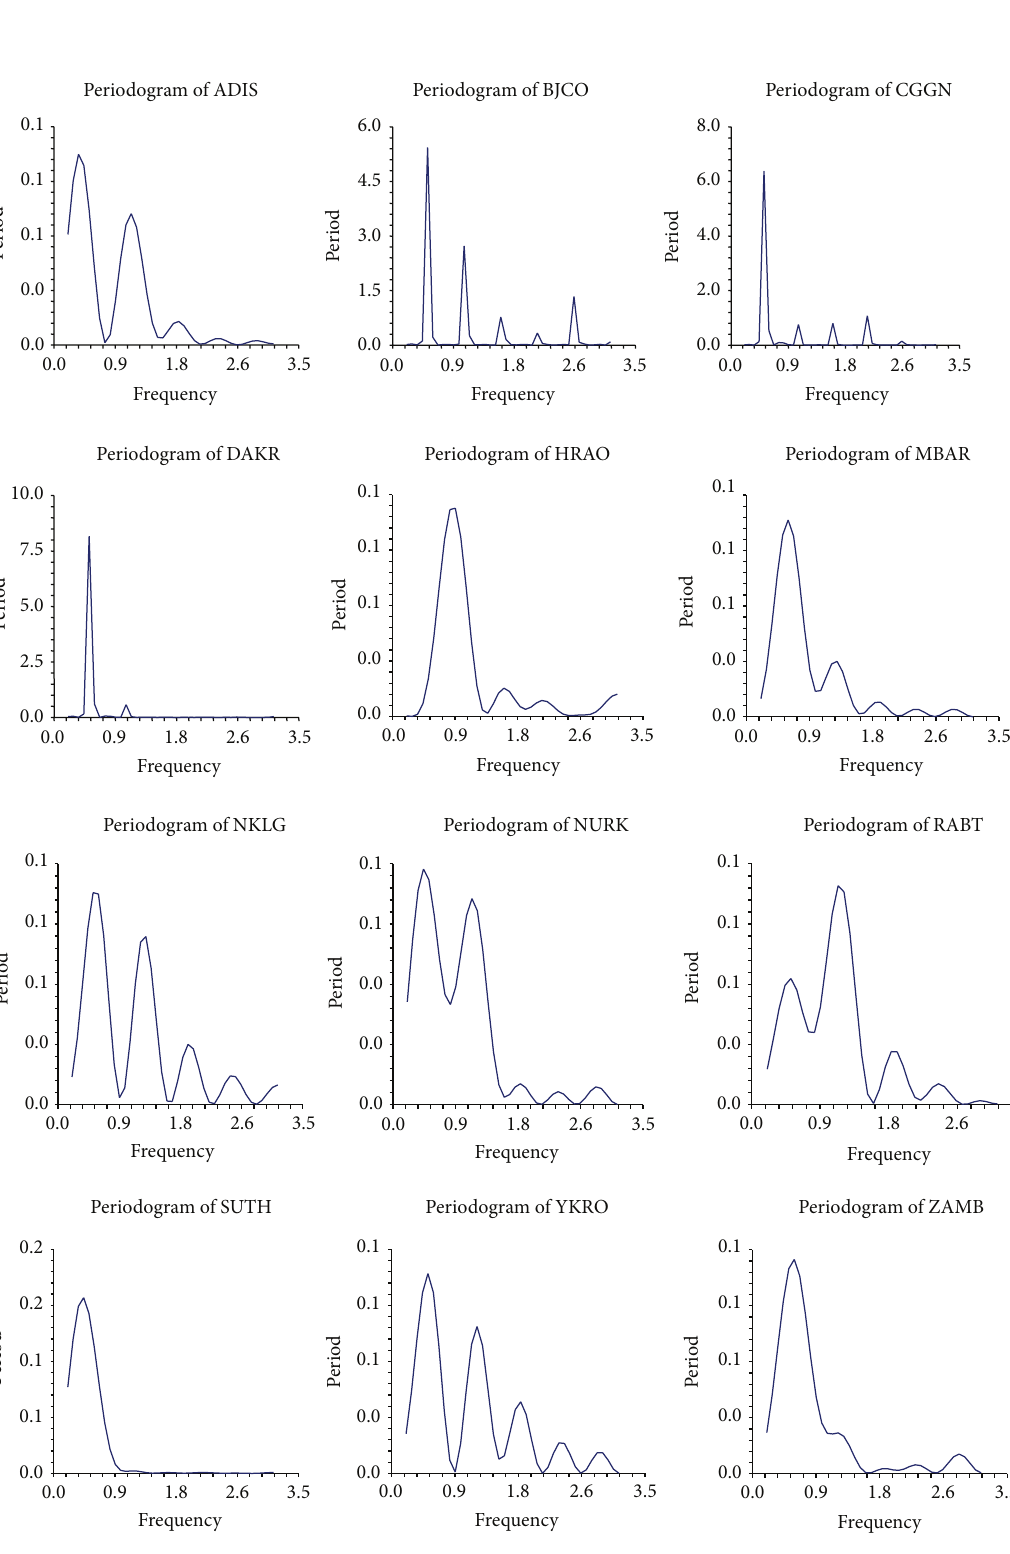
Figure 5: Periodogram graph of ZTD time